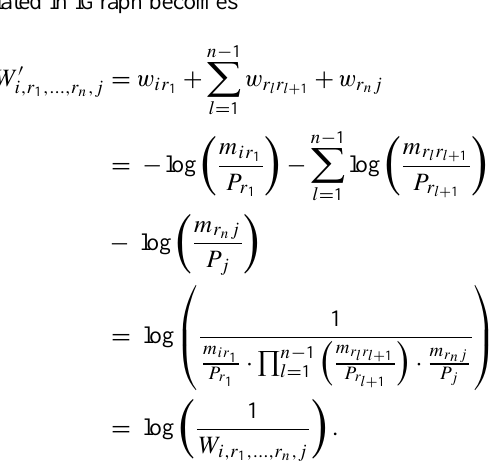
lated in iGraph